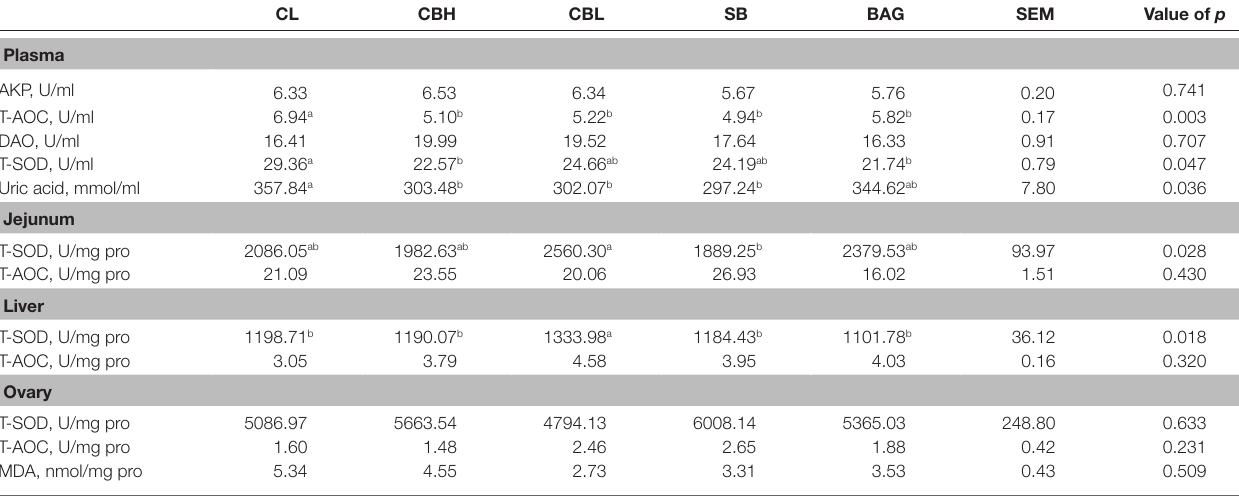
TABLE 5 | Biochemical variables of yellow-feathered breeder hens. CL CBH CBL SB BAG SEM Value of p